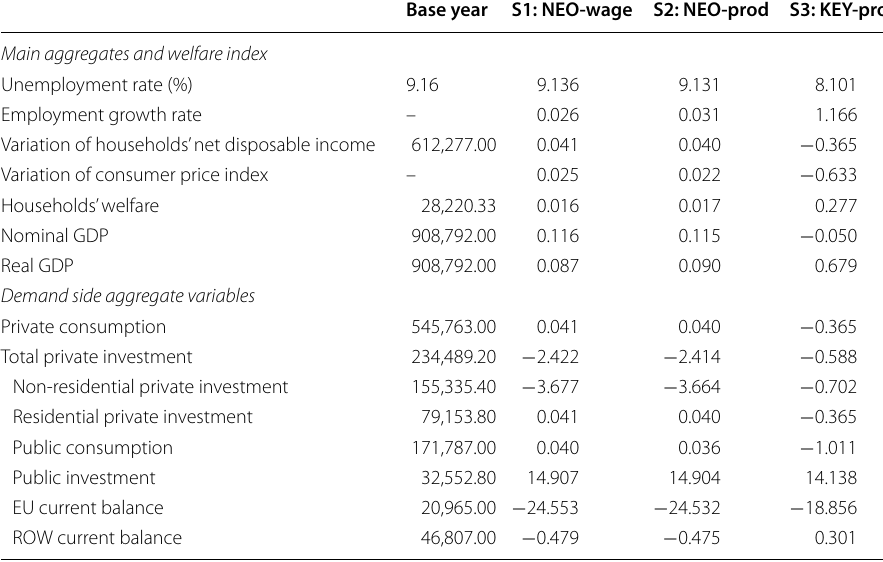
Table 8 Elasticities on the wage rate (S1) and elasticities of production multiplied (S2 and S3) by